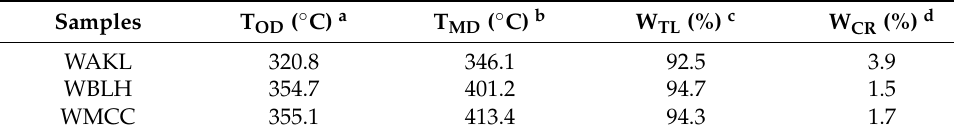
Figure 5. ( a ) TGA and ( b ) DTG graphs of WAKL, WBLH, and WMCC fibres. Table 3. Thermal analysis data of WAKL, WBLH and WMCC.